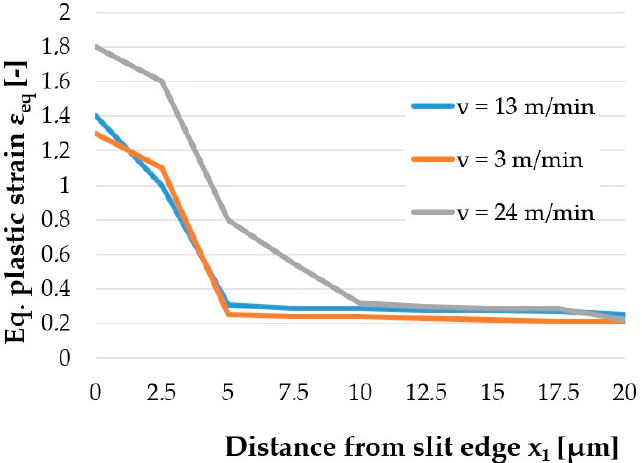
Figure 10. Effect of shear-slitting velocity v 2 on the equivalent plastic strain generated on cut edge.